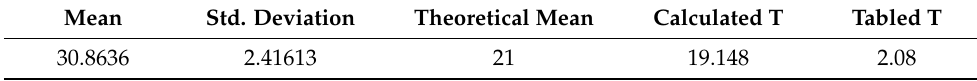
Table 12. The complete statistical analysis of the Effectiveness parameter. Mean Std. Deviation Theoretical